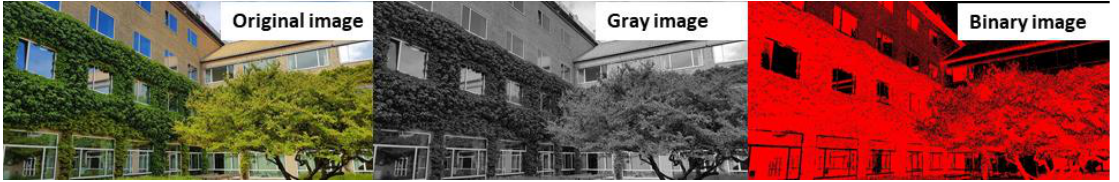
Figure 1. Comparison of an original color image with grey and binary images. Aarhus University campus, during 15th International Congress for Stereology and Image Analysis, Denmark 2019.